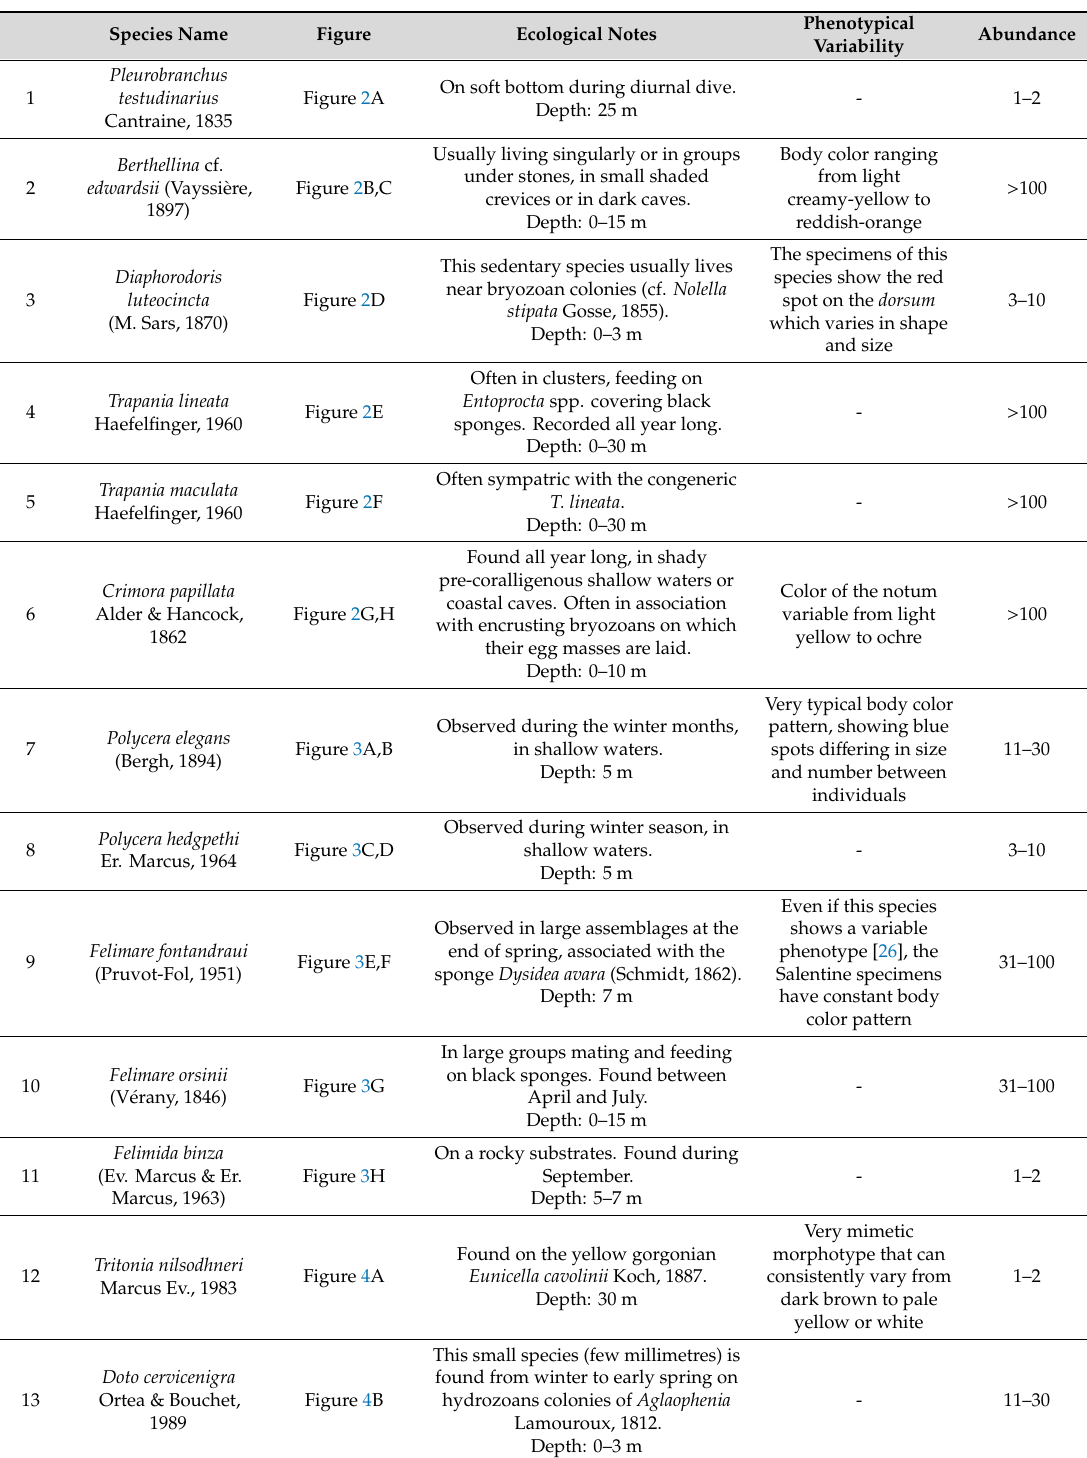
Table 3. List of the newly recorded Heterobranchia from the Salento peninsula; species names, relative figure numbers, ecological notes, and phenotypical variability for each added species are reported. Abundance is indicated as number of specimens.